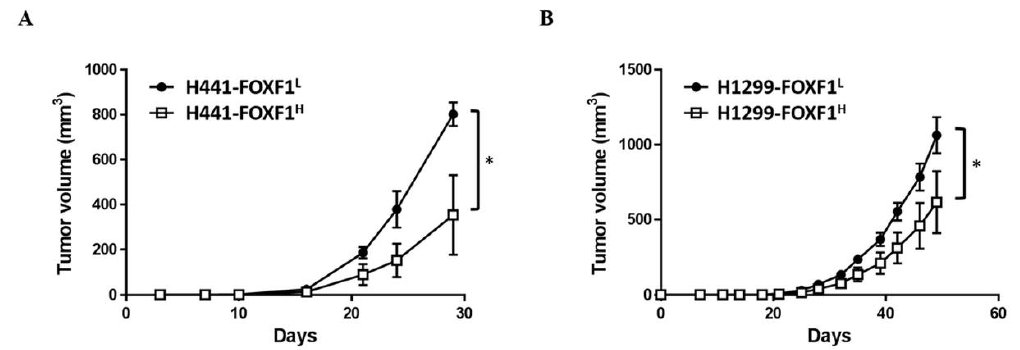
Figure 7. The in vivo anti-tumor effect of FOXF1 on non-small-cell lung cancer cell lines. Volumes of tumors generated by subcutaneous injection of highly expressing FOXF1 or control cell lines of ( A ) H441 and ( B ) H1299. Results are plotted as tumor volume versus days after implantation. * p < 0.05, using two-way ANOVA.